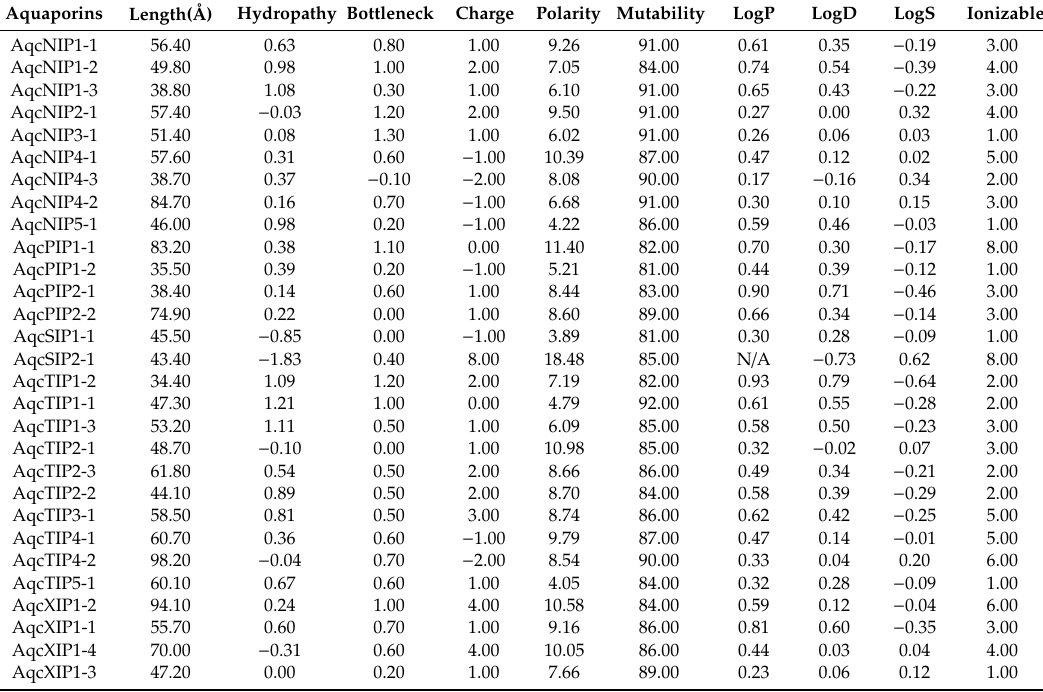
Figure 4. Predicted pore morphology of AqcNIP2-1 aquaporin identified in the Aquilegia genome. ( A ) Protein tertiary structure showing the pore morphology of AqcNIP2-1 along with features of the cavity, where red spheres represent the pore centers at a 1-Å step along the pore; ( B ) the pore diameter profile showing pore dimensions; ( C ) two-dimensional (2D) structure of AqcNIP2-1 showing an NPA motif, NPA–NPA spacing, an Ar / R selectivity filter, and Froger’s residue. Table 2. Physicochemical properties of the pore structure predicted for the Aquilegia aquaporins (AQPs). Three-dimensional structures of AQPs were predicted by using the Phyre2 server and subsequently visualized and analyzed using the Mole 2.5 server to predict the physicochemical properties of AQP pores, such as hydropathy, bottleneck, polarity, and